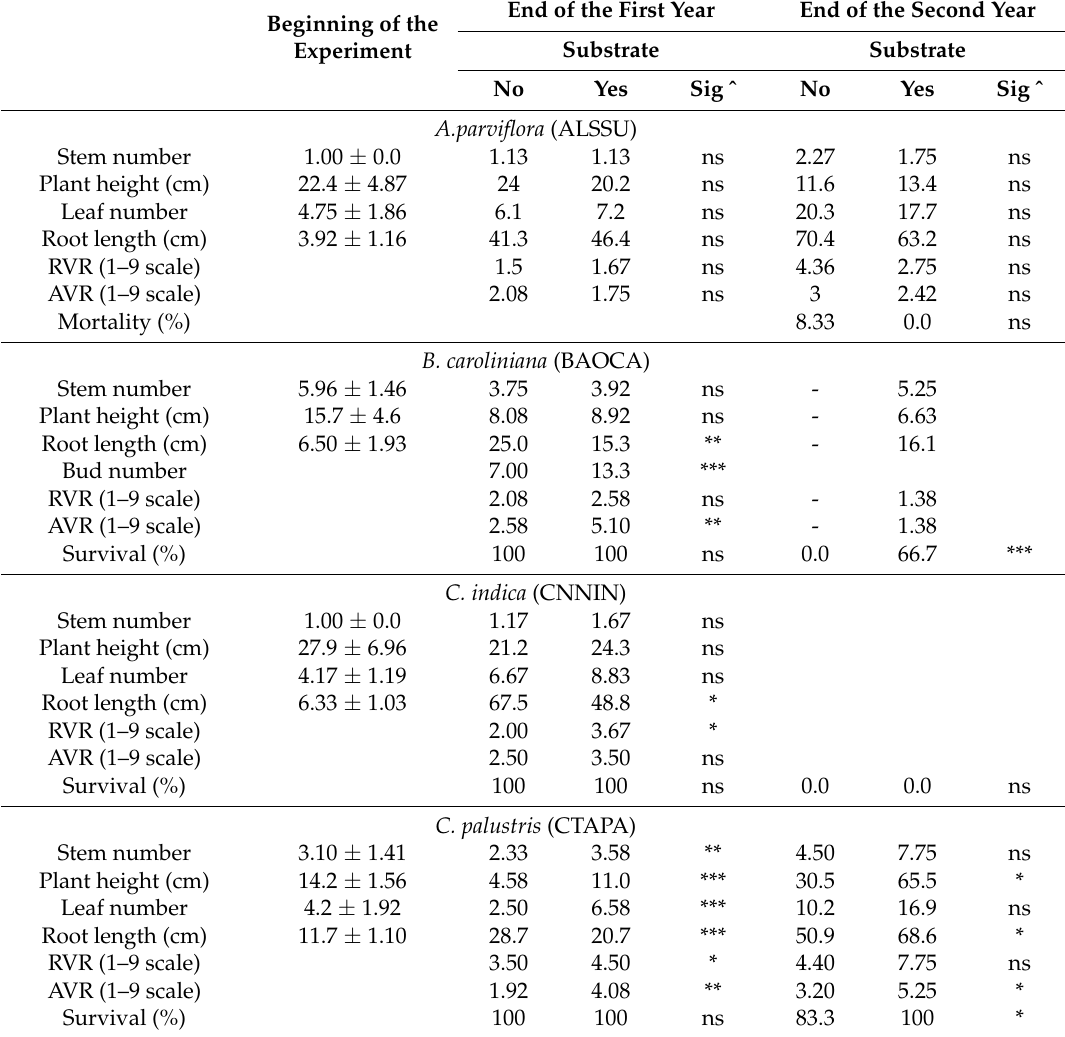
Table 2. Plants characteristics at the beginning of the experiment, at the end of the first year, and at the end of the second year (RVR = root visual score; AVR = aesthetic visual